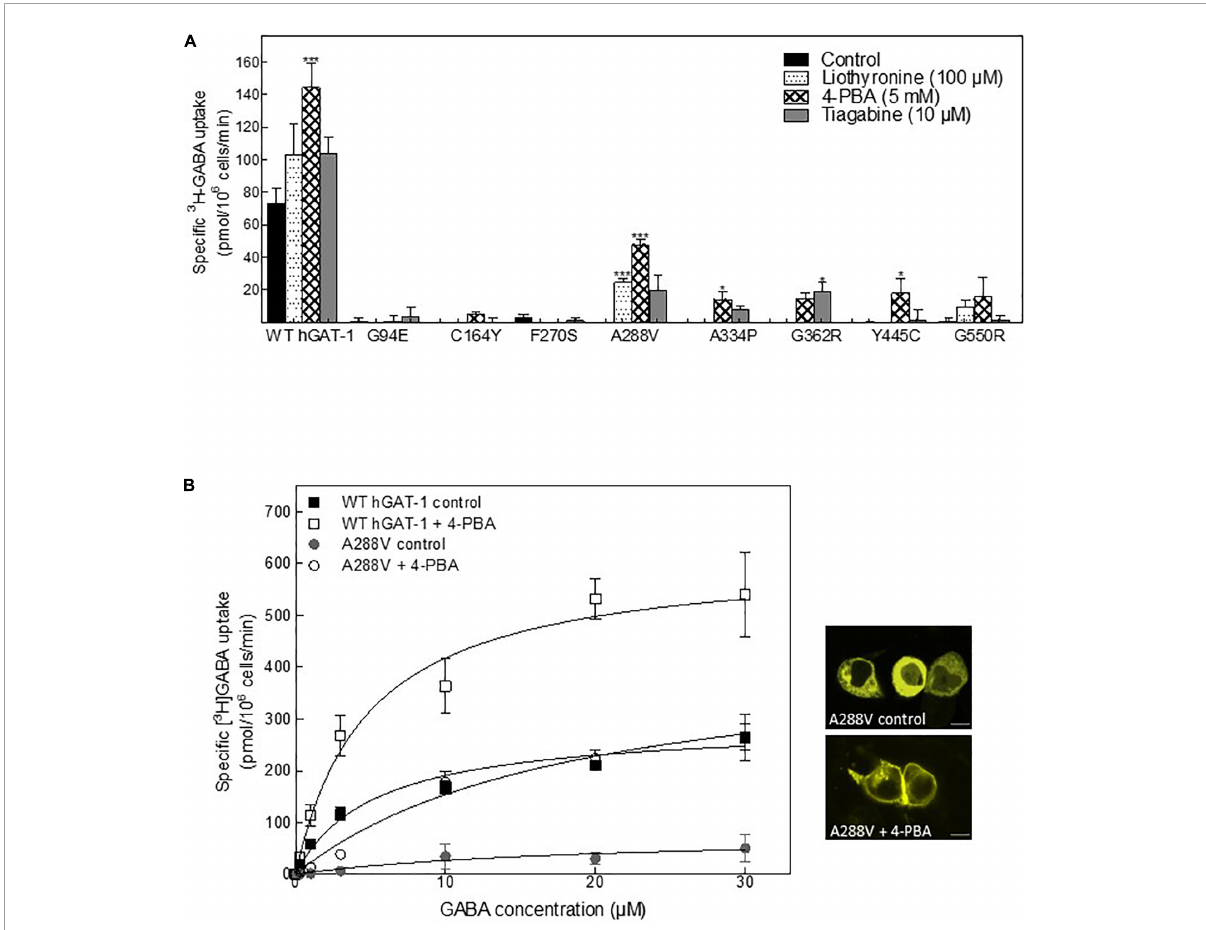
FIGURE5 Rescue of pathogenic human GABA transporter 1 (hGAT-1) variants by pharmacochaperoning. (A) HEK293 cells were transiently transfected with plasmids driving the expression of yellow fluorescent protein (YFP)-tagged WT hGAT-1 and epilepsy mutants thereof. After 24 h, the cells were seeded onto 48-well plates and treated with the indicated drugs [5 mM 4-phenylbutyrate (4-PBA), 100 µ M liothyronine and 10 µ M tiagabine] for a subsequent 24 h. The cells were extensively washed, to remove the inhibitors (liothyronine and tiagabine), prior to measuring specific [ 3 H]GABA uptake (3 min). (B) Michaelis-Menten [ 3 H]GABA uptake kinetics for WT hGAT-1 and the A288V variant, before and after 5 mM 4-PBA treatment, according to the procedure described under (A) . Right-hand panels show representative confocal miscroscopy images of HEK293 cells expressing A288V, under control and 4-PBA-treated conditions (scale bar = 10 µ m). The uptake data were obtained from at least three independent experiments (error bars = S.E.M.; The data were statistically compared by one-way ANOVA, followed by Tukey’s post-hoc t -tests (* p < 0.05, *** p < 0.001).